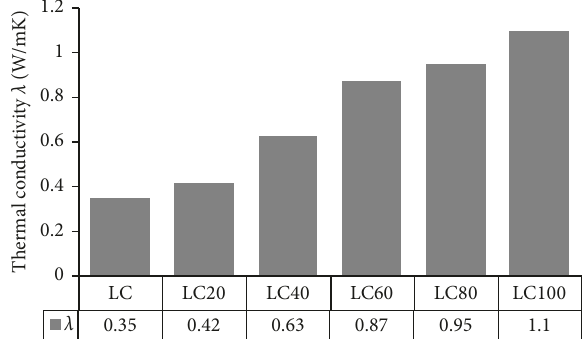
Figure 8: Effect of SWM dosage on the thermal conductivity of LC at